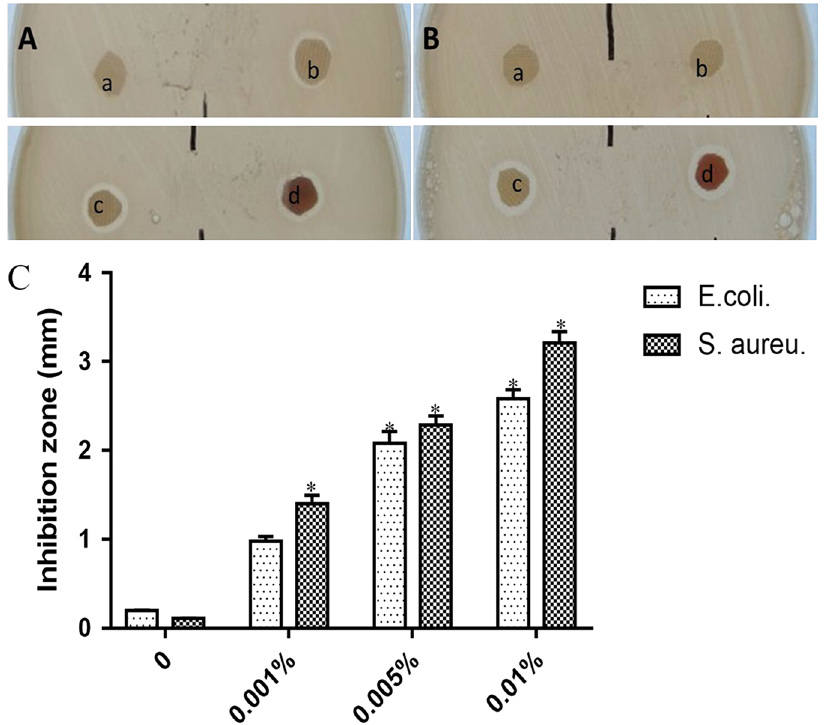
Figure 5. Antimicrobial studies of NAg-CCS against E.coli. and S. aureus. with diffenrent concentrations of NAg. Antimicrobial studies of NAg-CCS against E.coli . ( A ) and S. Aureus . ( B ). (a) CCS control, (b) CCS + 0.001% nanosilver, (c) CCS + 0.005% nanosilver and (d) CCS + 0.01% nanosilver. ( C ) The inhibition zone of different scafflods. * Indicates a statistically significant difference, P <